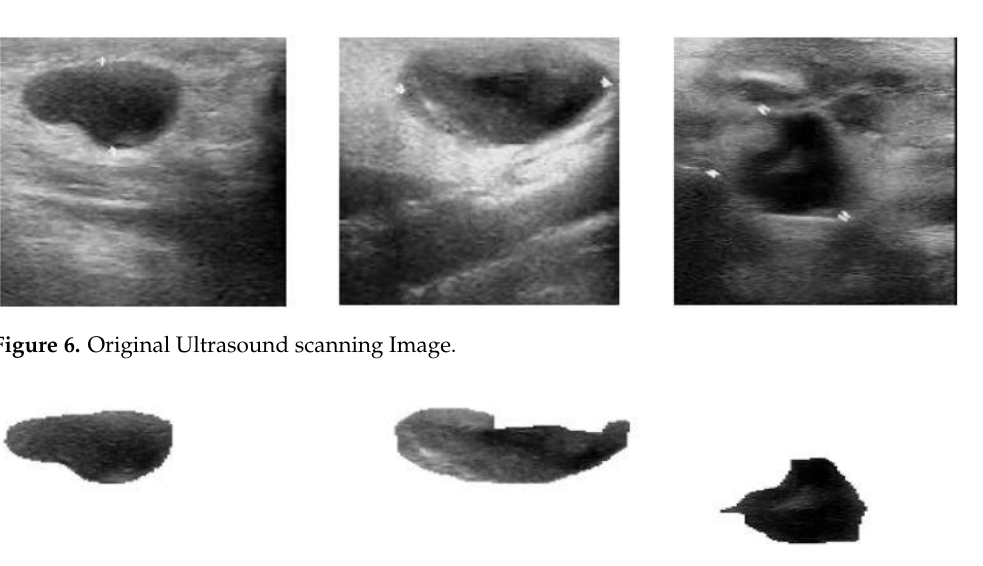
Table 1. Feature Extraction Formulas.